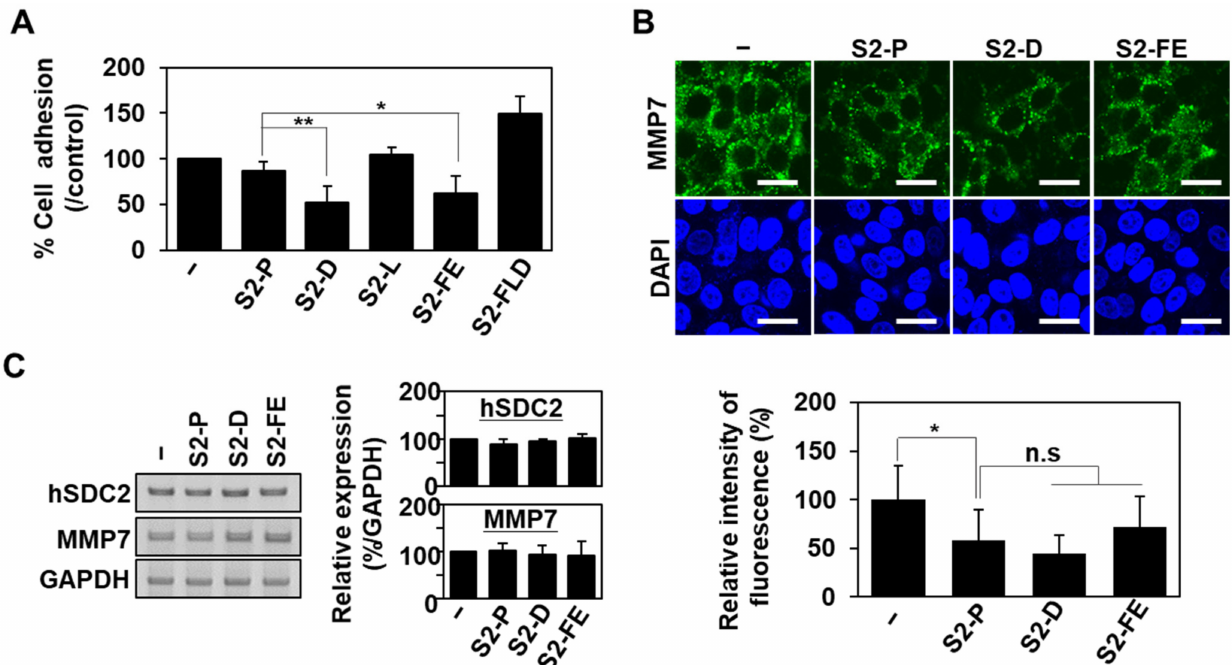
Figure 3. The synthetic peptides inhibited the interaction of SDC2 with the MMP-7 pro-domain. ( A ) HT29-SDC2 cells were plated on E-plates pre-coated with 10 µ g gelatin and 300 ng of PDMMP-7 in the presence of 50 nM of the indicated peptides. Cell attachment was monitored for 1 h and plotted using the RTCA software. Data are shown as mean ± S.D. ( n = 5); *, p < 0.05, **, p < 0.01 versus S2-P. ( B ) HT29-SDC2 cells pretreated with 50 nM of the indicated peptides for 24 h were incubated with anti-MMP-7 antibody and stained with an FITC-conjugated secondary antibody. Photographs were obtained under confocal microscopy. Scale bar: 20 µ m. Quantitative analysis of fluorescence intensity were performed using ImageJ program. Data are shown as mean ± S.D. ( n = 6); *, p < 0.05; n.s, no significant versus control or S2-P. ( C ) HT29-SDC2 cells were incubated with 50 nM of each peptide for 24 h, and the expression levels of the target mRNAs were analyzed by